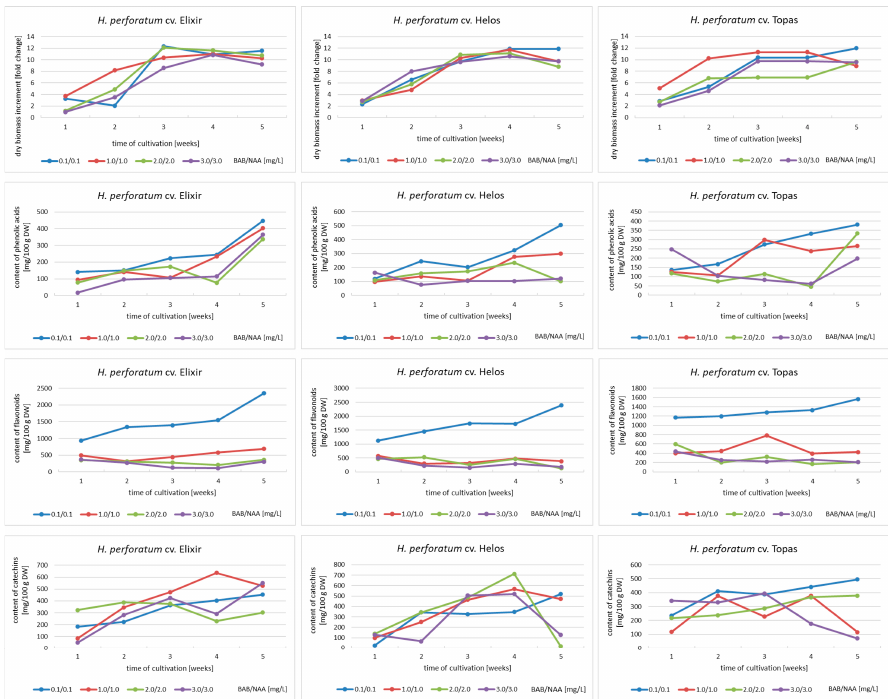
Figure 1. Dry biomass increments, and phenolic acid, flavonoid, and catechin contents in biomass extracts from agitated in vitro cultures of H. perforatum cultivars (Elixir, Helos, Topas) during 5-week growth cycles (MS medium variants with BAP and NAA). The metabolite content is expressed as the sum of the individual compounds determined by HPLC